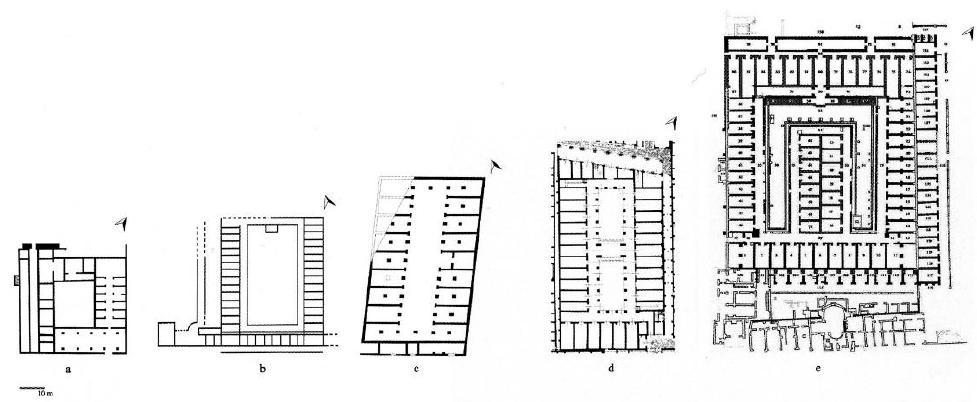
Figure 15. Comparison of the plan of some Western horrea of the Roman Empire [20] (Figure 2): (a)